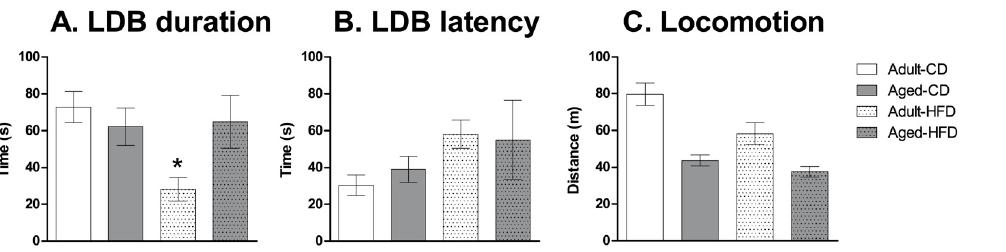
Fig 2. Effects of aging and exposure to high-fat diet on anxiety-like behavior and locomotor activity. Duration (s) in the light compartment ( A ) and latency to enter the light compartment ( B ) in the light-dark box test (LDB), and total distance travelled after 60 min in the open field ( C ) in adult and aged mice on a control diet (CD) or high-fat diet (HFD). Adult mice on the HFD spent less time in the light compartment than all other groups but no differences in the latency to enter the light compartment were observed. There were significant main effects of both age and diet on total distance travelled with aged mice travelling less than adult mice and mice on the HFD travelling less than mice on the CD diet. The data are expressed as mean ± SEM. * p < 0.05.